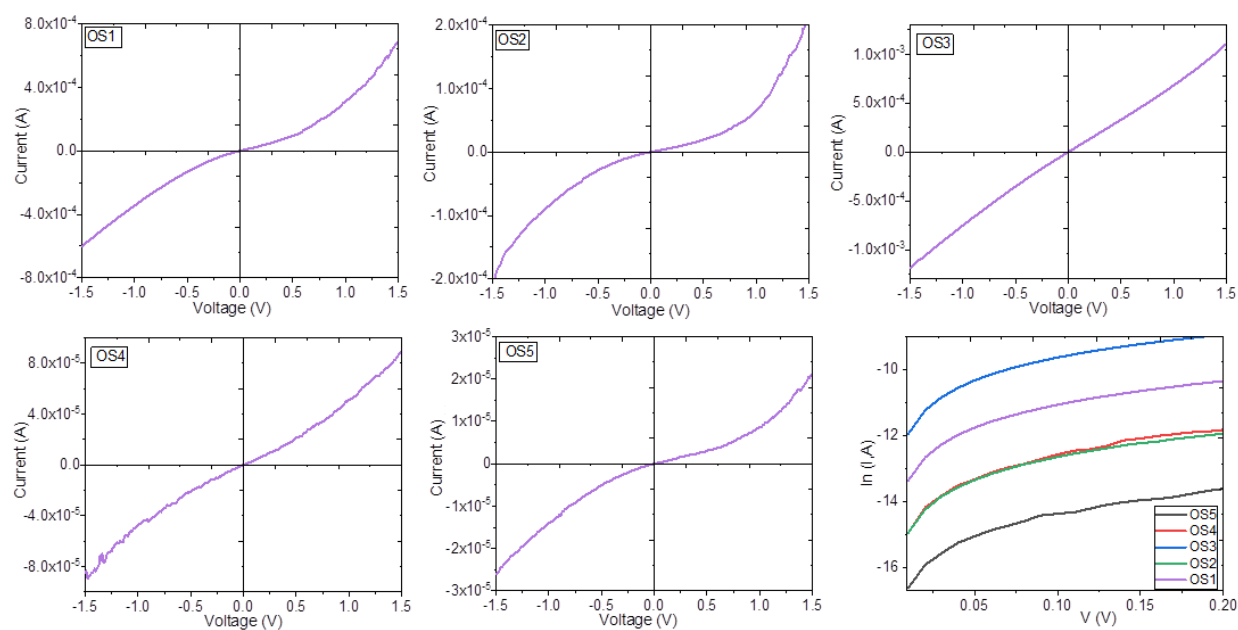
Figure 7. Current-Voltage (I-V) characteristic curves of the devices with OS films. Electrical conductivity ( σ ) is an important parameter; in semiconductor thin films, it increases with temperature. For each device, σ was evaluated at applied voltages of 0.1, 0.5, and 1.0 V and at different temperatures. Table 2 shows the values of σ at room tem- perature, while Figure 8 shows the temperature dependence of σ at 0.5 V within a tem- perature range of 25 to 100 °C. With respect to the results reported in Table 2, it is observed that, by increasing the voltage, an increase in the σ of the device occurs, with the OS5 device presenting the highest conductivity. However, σ values at room temperature for all devices are within the range for organic semiconductor materials (10 −6 to 10 −1 S·cm −1 ); this is important because an organic semiconductor is generally defined in terms of its the semiconductor film, in the vicinity of the electrodes, spatial charges are formed which oppose the flow of current through the semiconductor film. Beyond a certain threshold in the applied field, current saturation occurs. conductivity at room temperature. These results are related to the chalcone presence and the features it contributes to the semiconductor: (i) a high electronic delocalization, per- mitting charge transport; (ii) an increase in the BHJ contact surface, which improves exci- tonic diffusion between MnPcCl and the chalcone, and (iii) a BHJ-generated anisotropy, producing conduction channels for charge transport. For the results in Figure 8, in all the devices, conductivity increases with temperature, as expected for semiconductors. Within the range, conductivity increases by two orders of magnitude in OS4 and less than an order of magnitude in OS1 , OS2 , OS3 , and OS5 . These results supplement earlier studies regarding the use of MnPcCl – chalcone semiconducting films for optoelectronic applica- tions. Table 2. Electrical parameters of the devices with OS films. Device